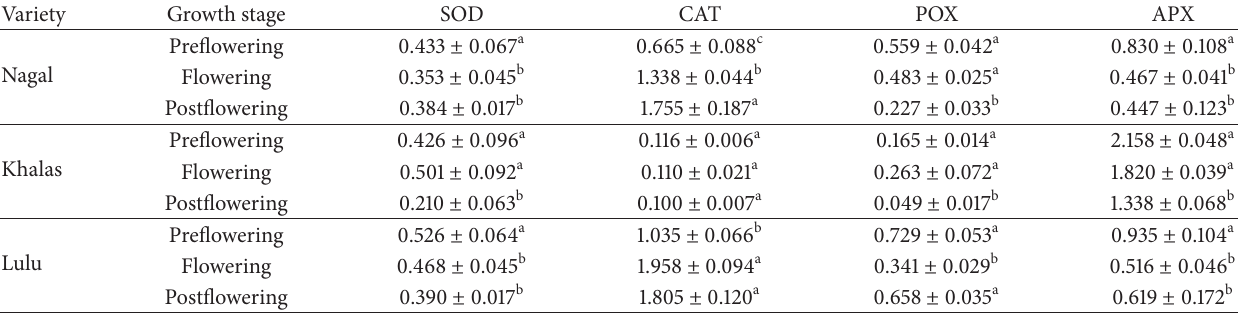
Table 3: Variation in antioxidant enzyme activities at different stages of growth in the early, mid, and late varieties of date palm.